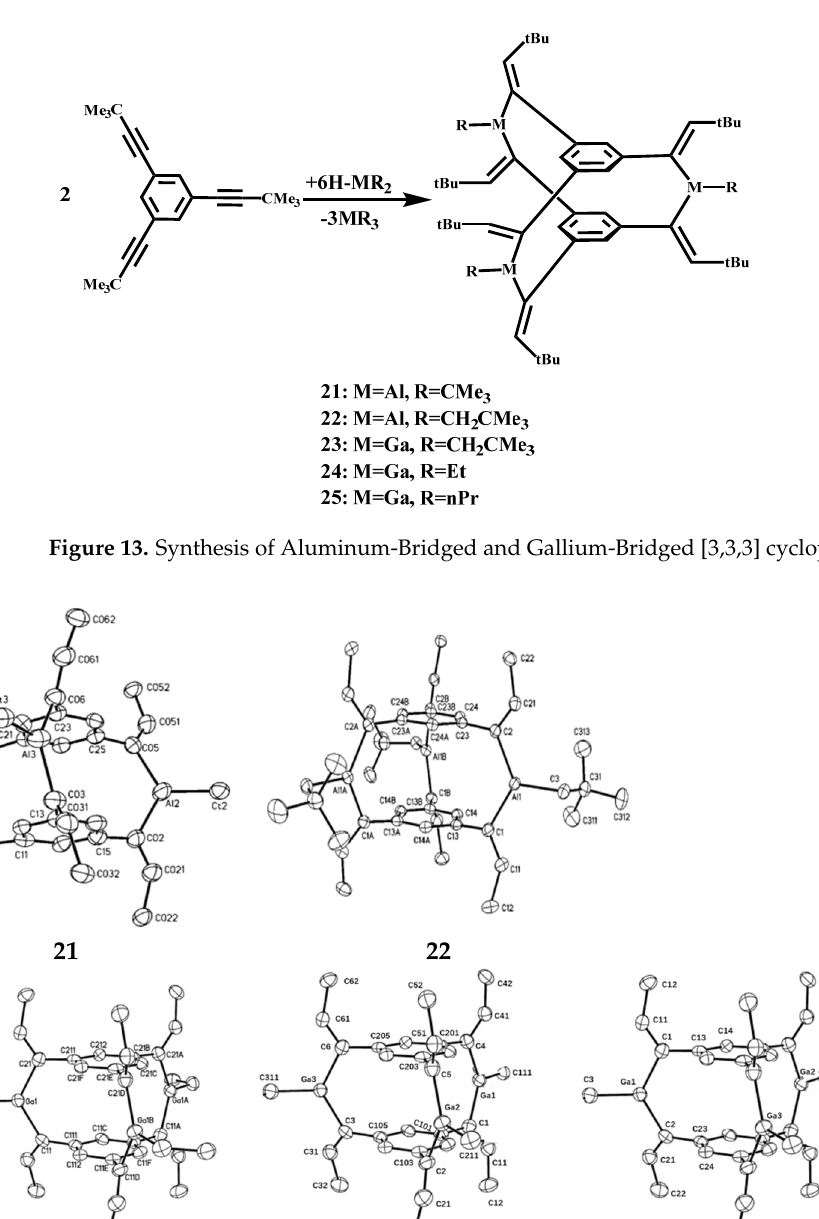
27 Figure 15. The structures of cyclophanes 26 and 27 and ORTEP drawings of complex 26 (the probability of thermal ellipsoid is 50%). Yuan et al. obtained a speleand imidazolium cyclophane [C 30 H 33 N 6 ] 3+ ·3Br − ·3H 2 O] 28 by direct quaterization of 1,3,5-trimethyl-2,4,6-tri (imidazolylmethyl) benzene with m-tri(bromomethyl)benzene and its yield is 89% [50], the reaction is shown in Figure 16. The repeating crystal structural unit consists of one large bicyclic triimidazole cyclopean, three bromine anions, and three water molecules. The three imidazole rings and the two benzene rings are surrounded by a cavity, the three imidazole rings are asymmetrically arranged, and there is no symmetry factor in the molecule itself, but the imidazole ring is